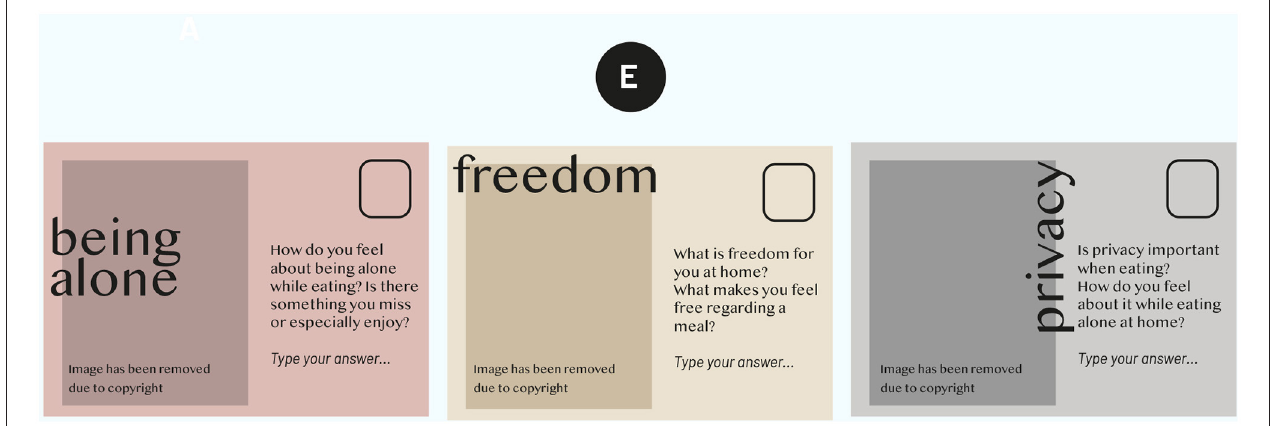
FIGURE 2 | Overview of activity (E) included in the cultural probe kit. Images included on the postcards have been removed due to copyright. The images of part (E) showed different people to illustrate the focus of the postcards, e.g., the postcard of “being alone” showed a person and a cat looking out of a window. The postcard focusing on “freedom” showed a person sitting outside using a smartphone, and the postcard about “privacy”, a person sitting on a chair looking into the camera.